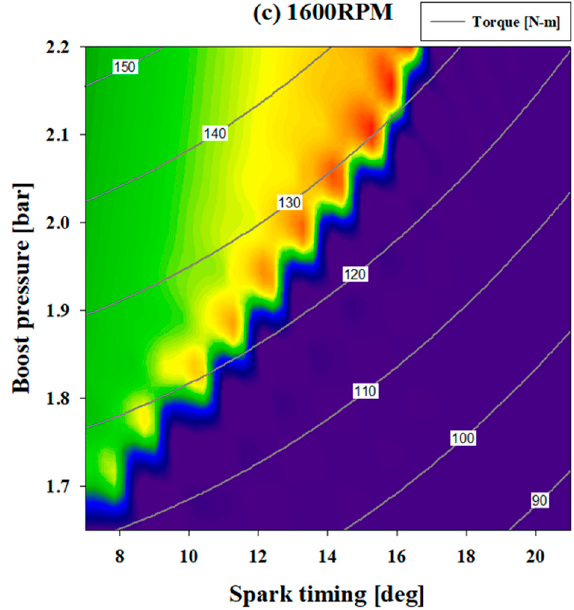
Figure 7. ( a ) Predicting knocking phenomenon according to changes in spark timing and boost pressure at 1600 RPM. ( b ) Predicting NOx amounts according to changes in spark timing and boost pressure at 1600 RPM. ( c ) Predicting torque tendency according to changes in spark timing and boost pressure at 1600 RPM.